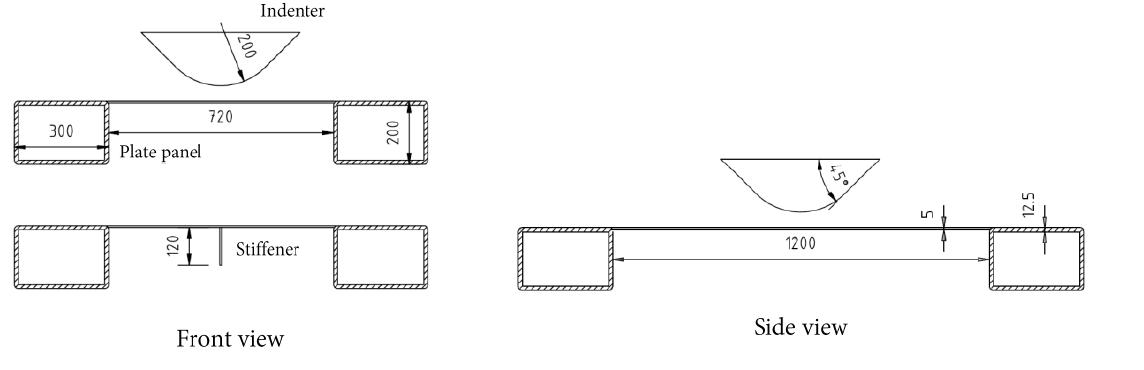
Figure 3. Designed plate panel for the penetration test [31]. Table 1: Applied material on the plate panel for the penetration test Material and specimen